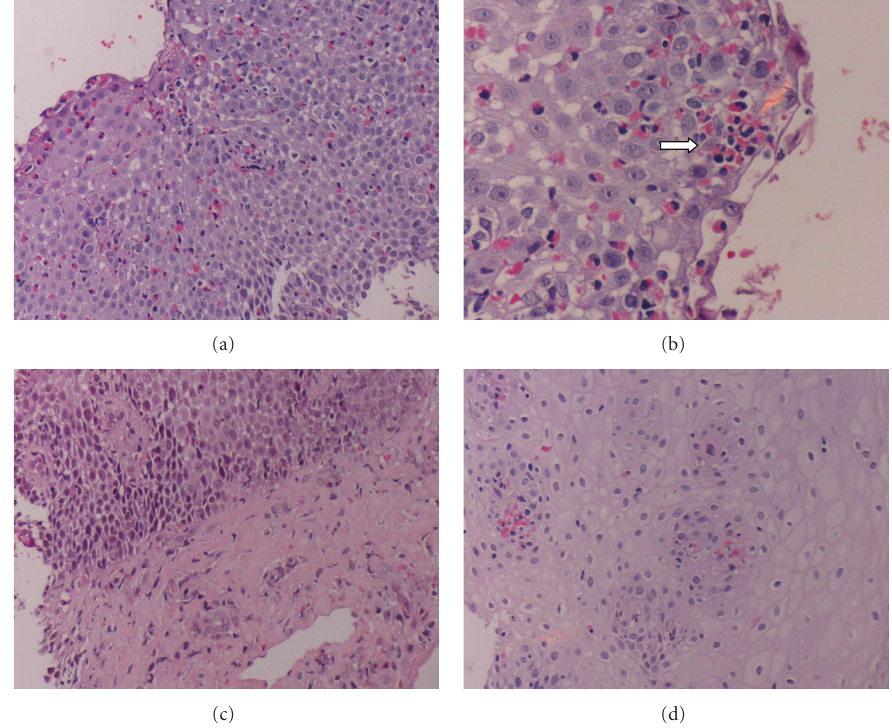
Figure 2: Histopathological abnormalities in our patients with EE. (a) Esophageal mucosa in a patient with eosinophilic esophagitis. Note the marked eosinophilic infiltration close to the surface (20X). (b) An aggregate of eosinophils forming eosinophilic microabscess (arrow) (40X). (c) Fibrosis of lamina propria and lamina propria eosinophils (20X). (d) Follow-up biopsy showing marked reduction in intraepithelial eosinophils and absence of eosinophilic microabscess, intercellular edema, and basal cell hyperplasia (20X).